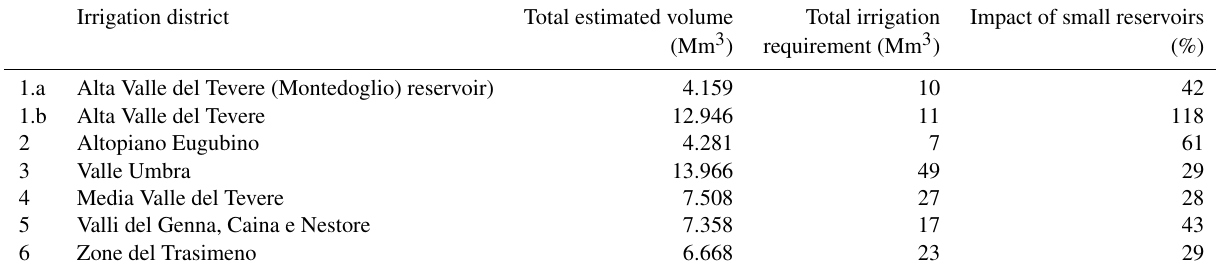
Table 4. Estimated volumes at irrigation district level. Irrigation district Total estimated